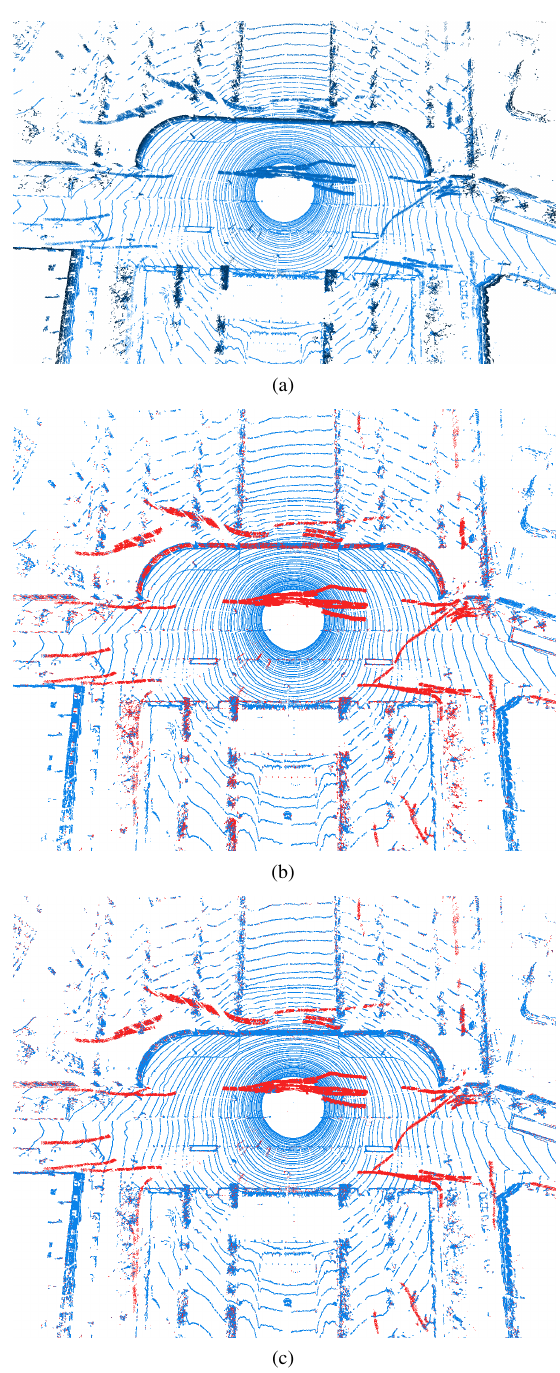
Figure 2: Moving object detection using laser scanning system, (a) original data during about 15 s, (b) Max-Distance, and (c) Nearest-point methods. The former is simple and fast, whereas the later is robust to penetrable objects, as seen in (c) there are much less false alarms (red) on fences and